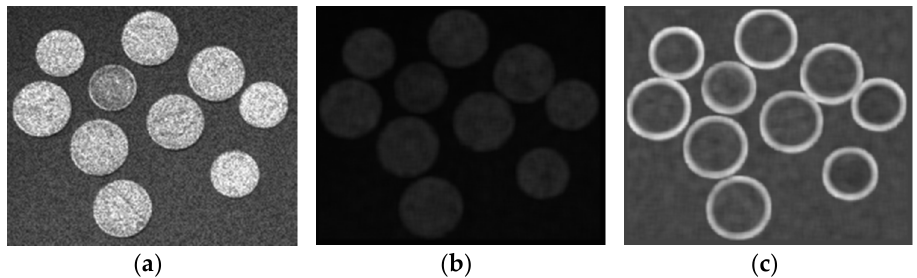
Figure 4. Comparisons of the CV performance and performance of the Standard deviation of the image ( a ). Noisy image ( b ). the result of applying the Standard deviation on noisy image ( c ). the result of applying the CV on noisy image.